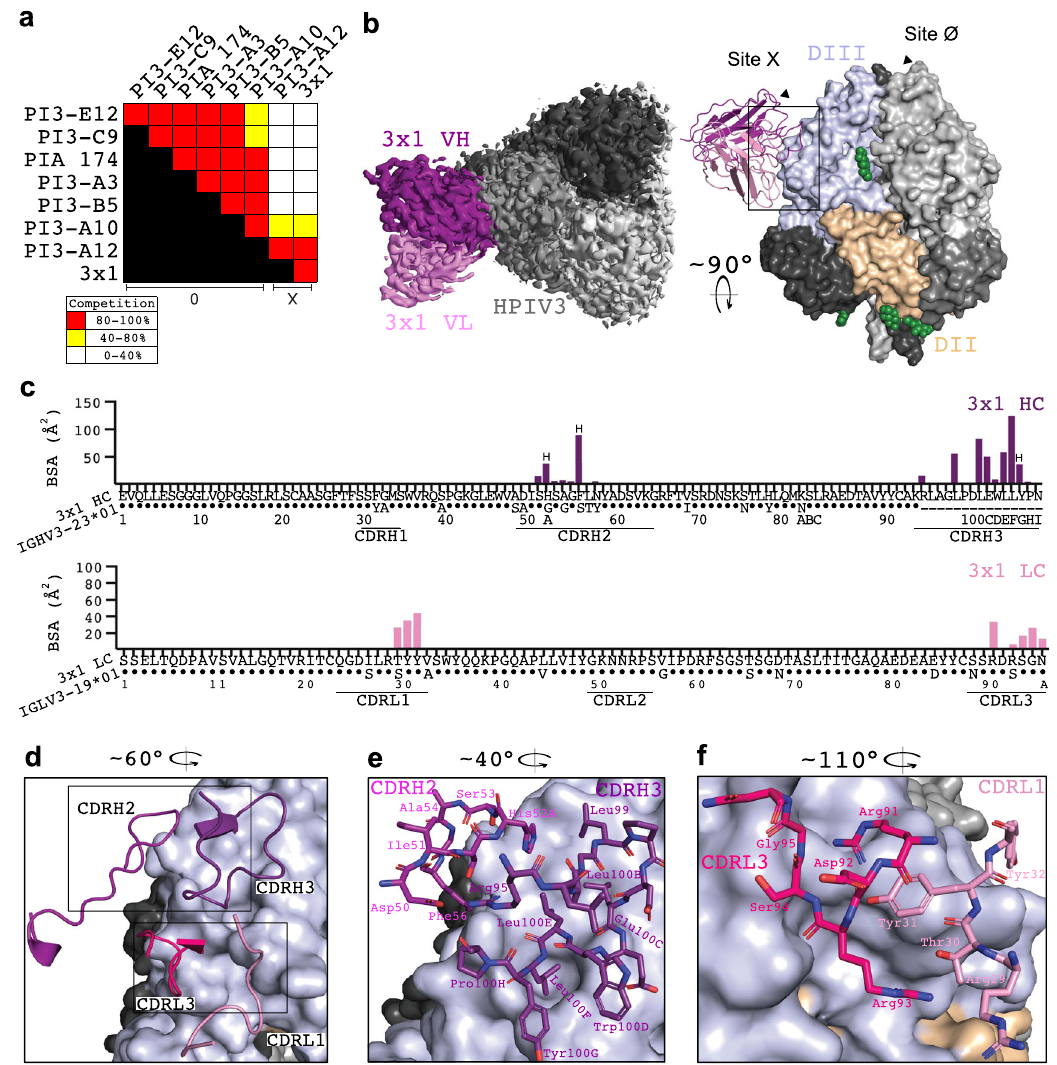
Fig. 2 |AnalysisoftheHPIV3preFepitopeboundby3×1. a BLI measurementof the ability of the mAb listed on the left side of the chart to prevent binding of the mAblistedonthetop,expressedasthepercentdropinmaximumsignalcompared to the maximum signal in the absence of competing mAb. b Cryo-EM structure of 3×1FabincomplexwithHPIV3preF.Left,atop-downviewofthe3×1:HPIV3mapis shown with one Fab (V H shown in purple, V L in pink) and HPIV3 preF in shades of gray. Right, a surface representation of the complex is shown rotated 90° with domainIIIinlightblueanddomainIIinyellowononeprotomer.Glycansareshown